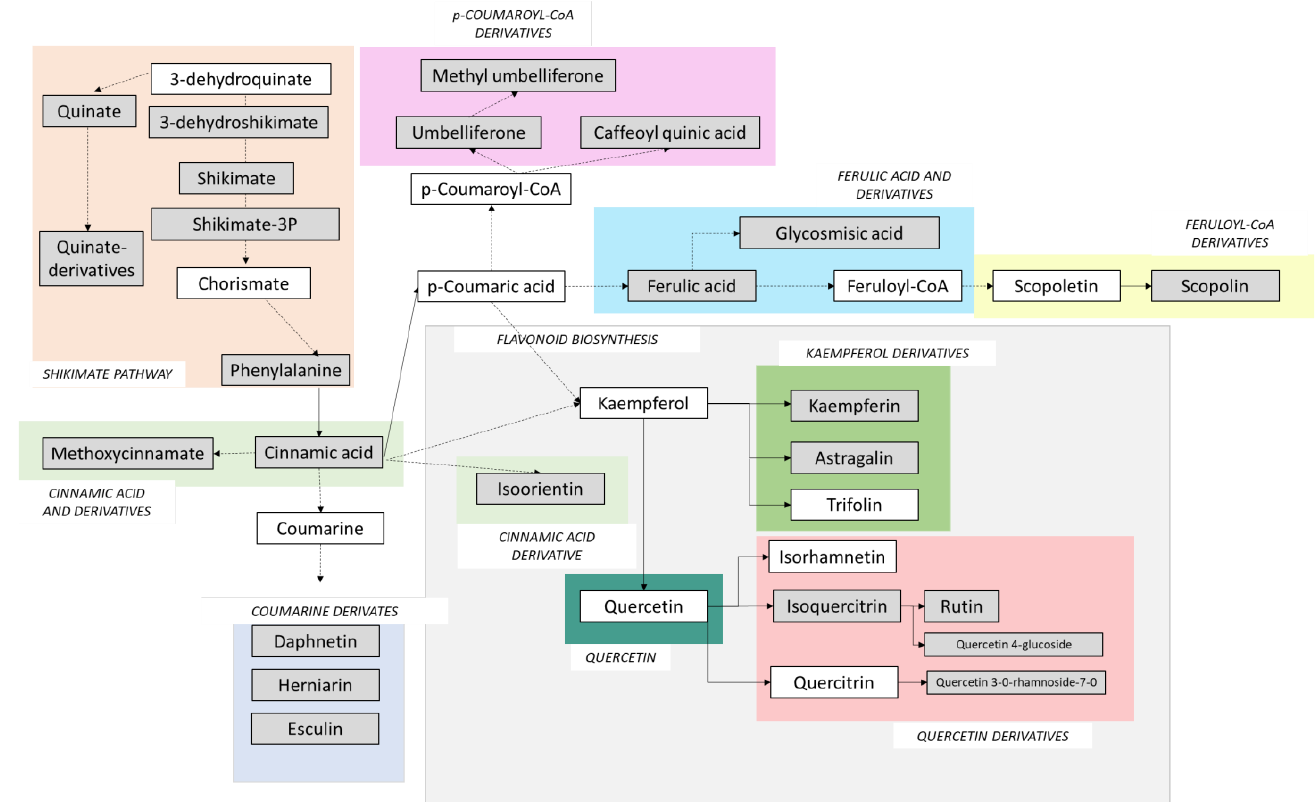
Figure 6. Simplification of the phenylpropanoid and flavonoid (squared in light grey) biosynthetic pathways and connection with the shikimate pathway. Metabolites in grey represent compounds found and annotated in this study. Metabolites in white were not detected or not positively anno- tated in this study. One-step reactions are represented by arrows with continuous lines. Reactions containing more than one step are represented by arrows with discontinuous lines. Different colors define chemical groups used for data plotting (Figures 7 and 8).